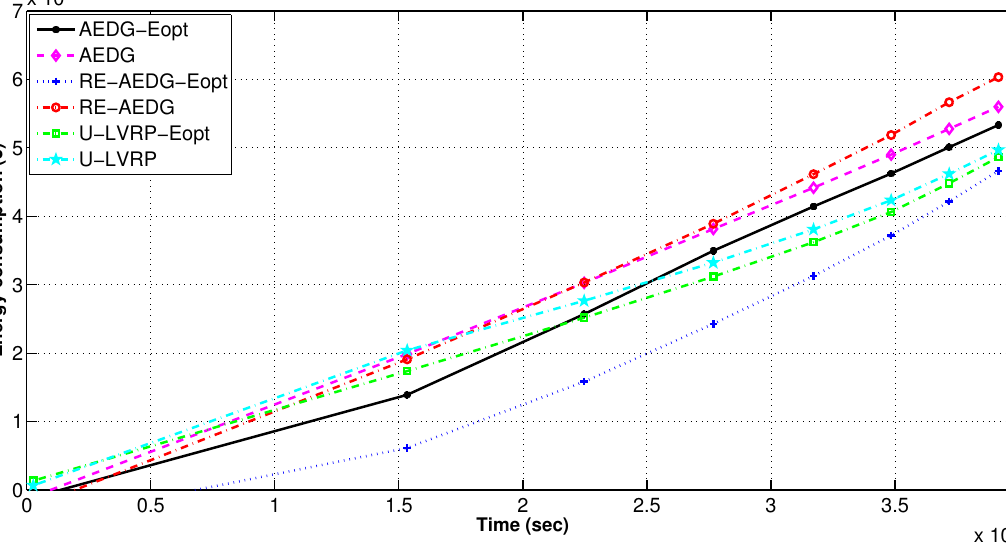
Figure 13. Energy consumption in energy optimized and non optimized